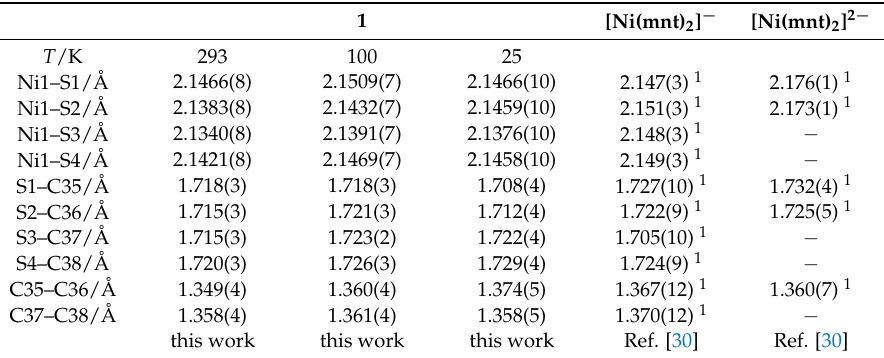
Table 3. Selected bond lengths of the [Ni(mnt) 2 ] molecule.